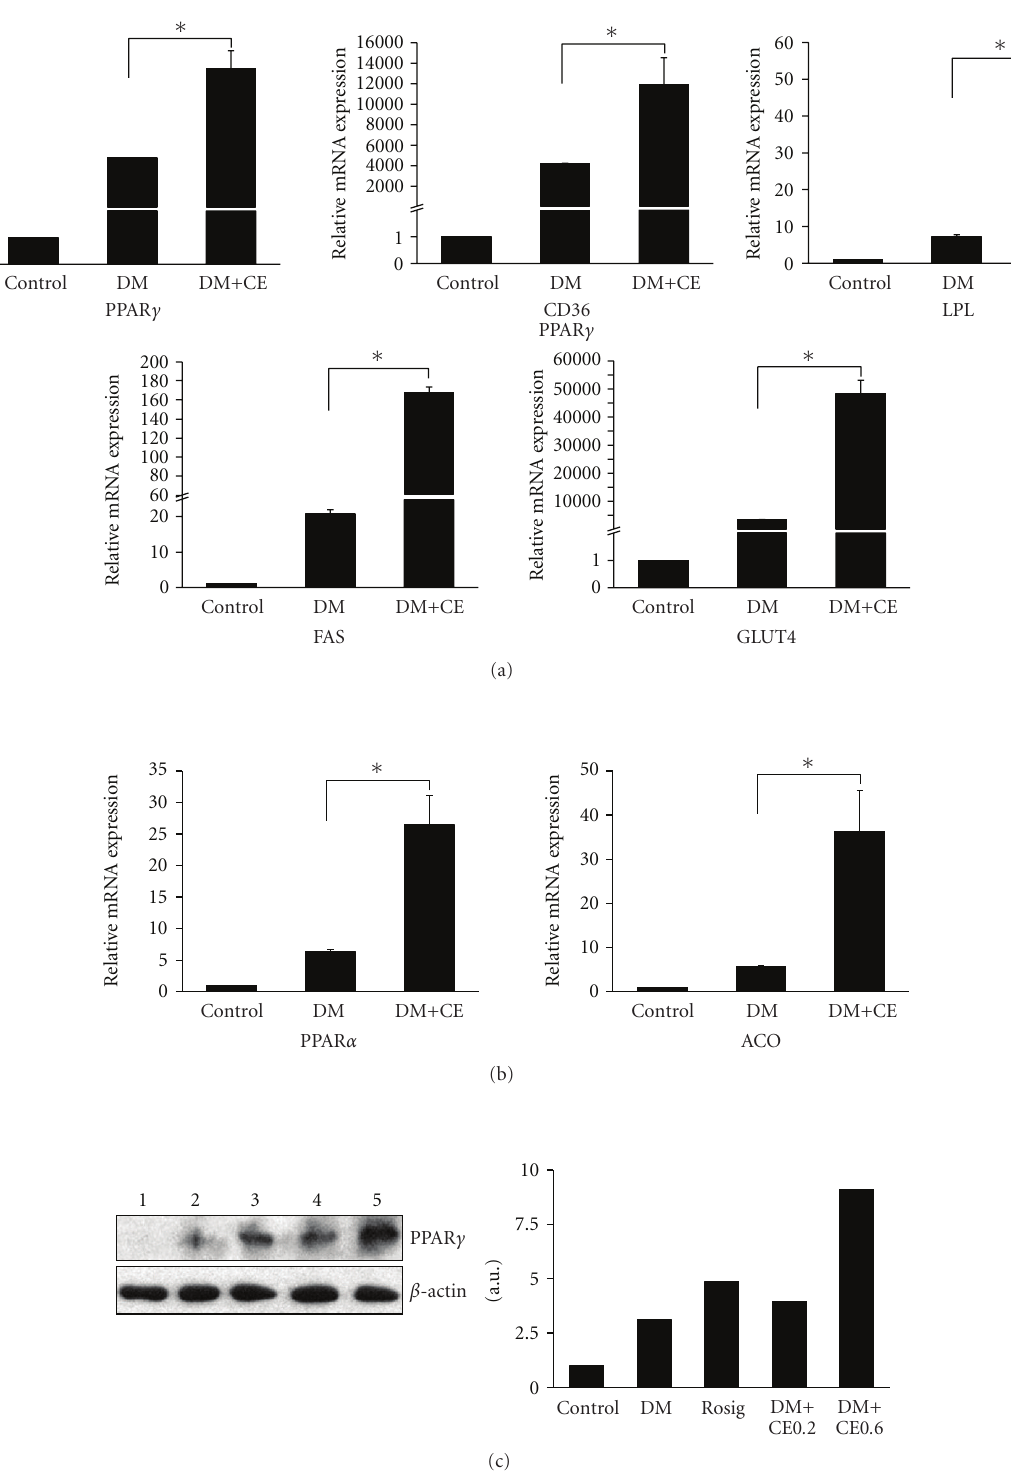
Figure 3: CE increased expression of PPARs and their target genes in di ff erentiated 3T3-L1 cells. 3T3-L1 cells were di ff erentiated in 24-well plate and CE 0.6mg/mL was added at the same time. On day 5, cells were collected and total RNA was extracted and reversely transcribed into the first strand cDNA with random hexamer primers using cDNA synthesis kit. The gene expression levels were analyzed by quantitative real-time RT-PCR. (a) PPAR γ and its target genes; (b) PPAR α and its target gene; (c) Western blot of CE-treated 3T3-L1 di ff erentiated cells from day 5. 1: Control; 2: DM; 3: Rosiglitazone 1 μ M; 4: DM + CE 0.2 mg/mL; 5: DM + CE 0.6 mg/mL. For real-time PCR, the results were repeated in at least 3 independent experiments, and β -actin mRNA was used as an internal control. Data are presented as mean ± SE. ∗ P < .